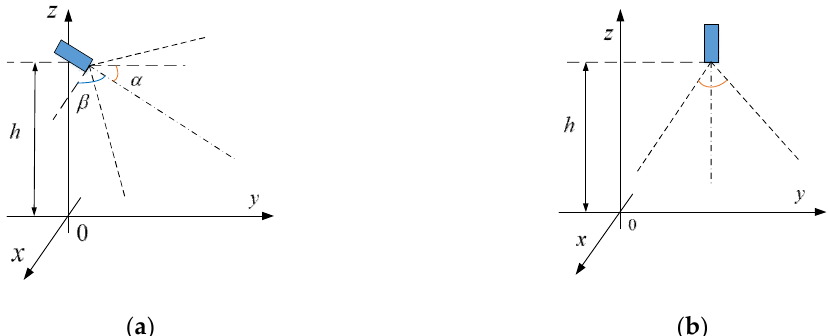
Figure 3. Comparison of the image perspective: ( a ) Image of inverse perspective; ( b ) Image of aerial view.